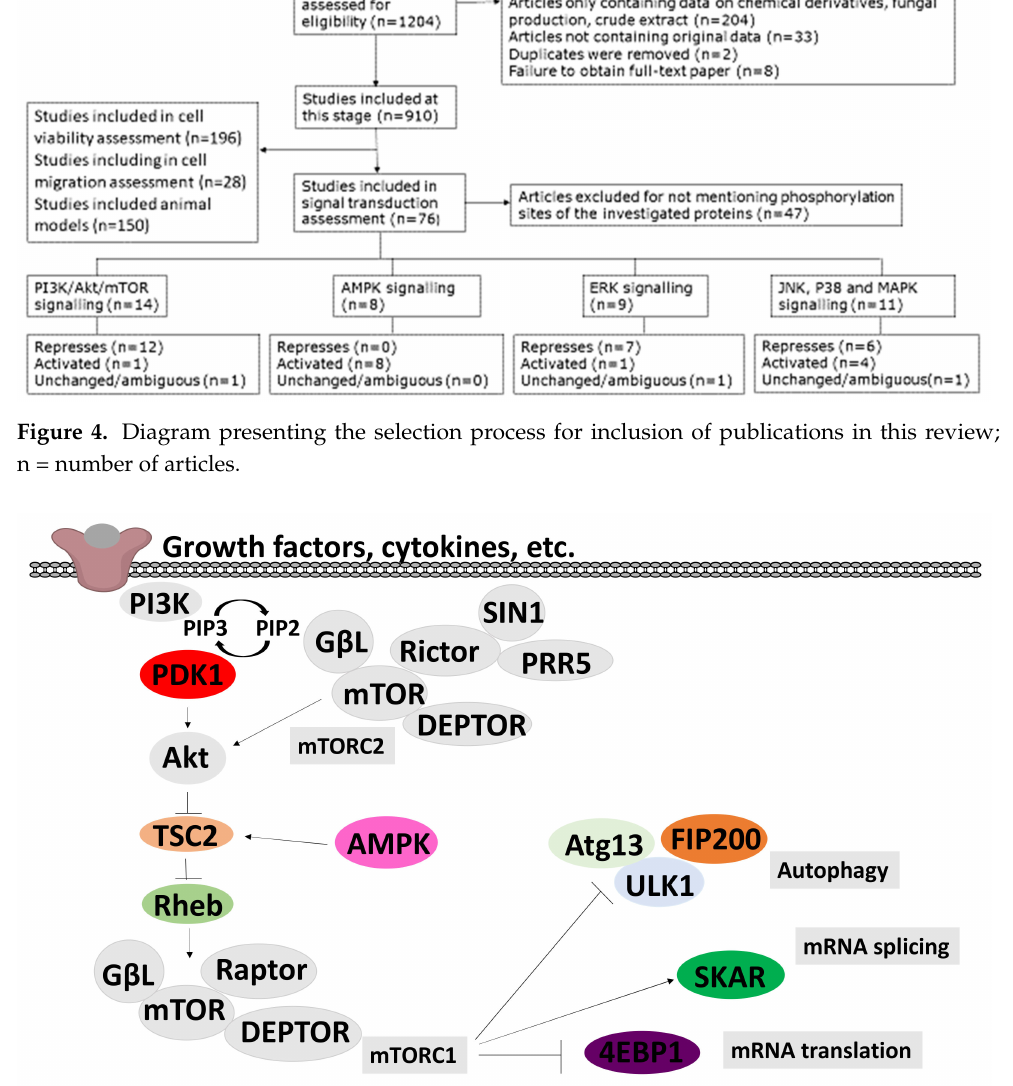
Figure 5. A schematic model of the PI3K/Akt/mTOR signalling pathways. This model integrates PI3K/mTOR/Akt and AMPK signal transduction pathways. Arrows indicate activation and T ends indicate inhibition. Triggered PI3K activates Akt/mTOR cascade, through activation of PDK1 and phosphorylation of AKT in the activation T-loop. mTOR complex 2 (mTORC2), is activated by an as- yet unknown pathway and contributes to the activation of AKT by phosphorylation in the C-terminal. AKT inhibits TSC2, which leads to activation of the small GTPase Rheb and activation of the mTOR complex 2 (mTORC2). The pathway is negatively regulated by AMPK, through activation of TSC2. The PI3K/Akt/mTOR signalling pathway increases protein synthesis through the phosphorylation of the cap-dependent translation inhibitor protein 4EBP1 and inhibits autophagy, leading to the promotion of growth and the anabolic